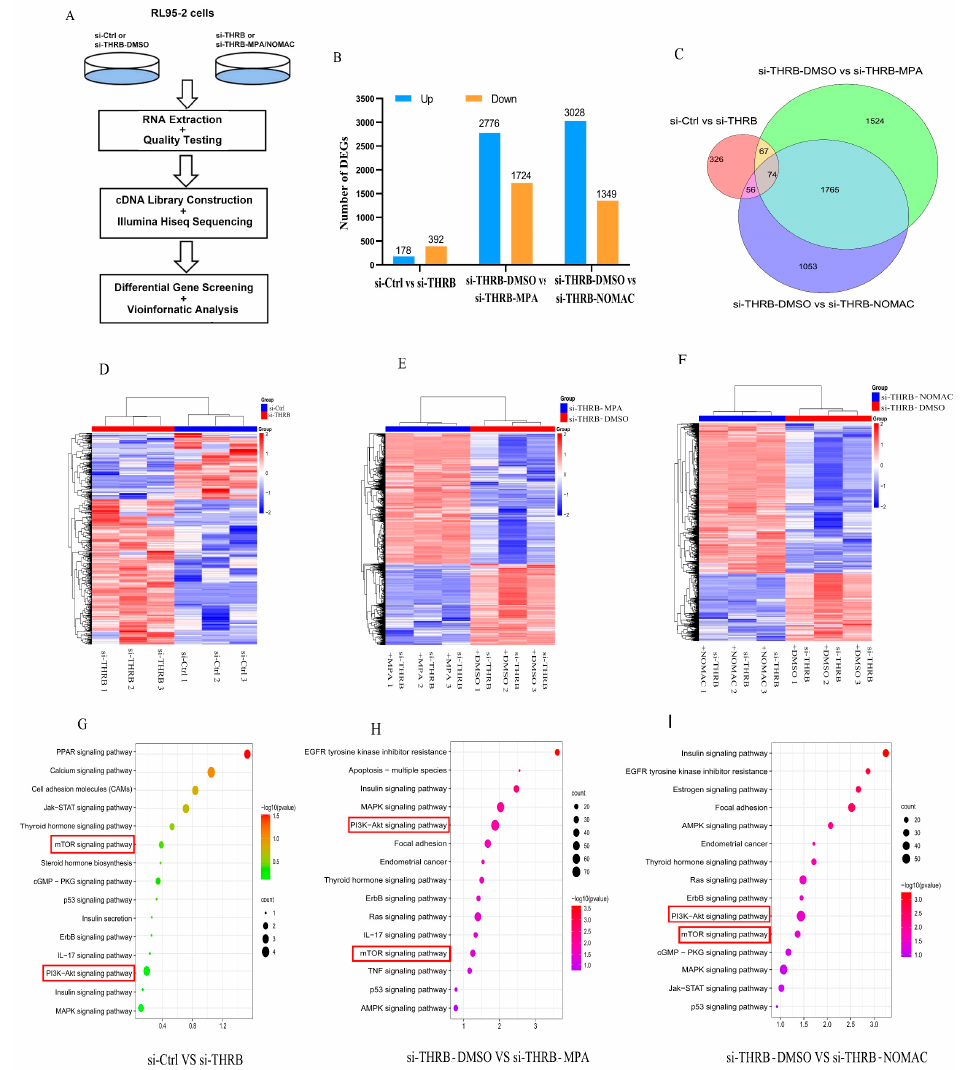
Figure 5. Functional enrichment analysis of DEGs and enriched signaling pathways. ( A ) Transcriptomics flowchart. ( B , C ) Column chart and Venn diagram showing the number of DEGs up and down-regulated in the si-Ctrl versus si-THRB, si-THRB-DMSO versus si-THRB-MPA and si-THRB-DMSO versus si-THRB-NOMAC groups. ( D ) Heatmap of DEGs between si-Ctrl-RL95-2 and si-THRB-RL95-2 cells. ( E ) Heatmap of DEGs between DMSO and MPA treatments in THRB-silenced RL95-2 cells. ( F ) Heatmap of DEGs between DMSO and NOMAc treatments in THRB-silenced RL95-2 cells. ( G ) KEGG enrichment analysis of DEGs between si-Ctrl-RL95-2 and si-THRB-RL95-2 cells. ( H ) KEGG enrichment analysis of DEGs between si-THRB-DMSO-RL95-2 and si-THRB-MPA-RL95-2 cells. ( I ) KEGG enrichment analysis of DEGs between si-THRB-DMSO-RL95-2 and si-THRB-NOMAC-RL95-2 cells. The results are presented as mean ± SEM of three independent experiments. THRB, thyroid hormone receptor beta; si-Ctrl, negative control treated with siRNA solvent; si- THRB, silenced THRB; MPA, medroxyprogesterone acetate; NOMAc, nomegestrol acetate; DEGs, differentially expressed genes .